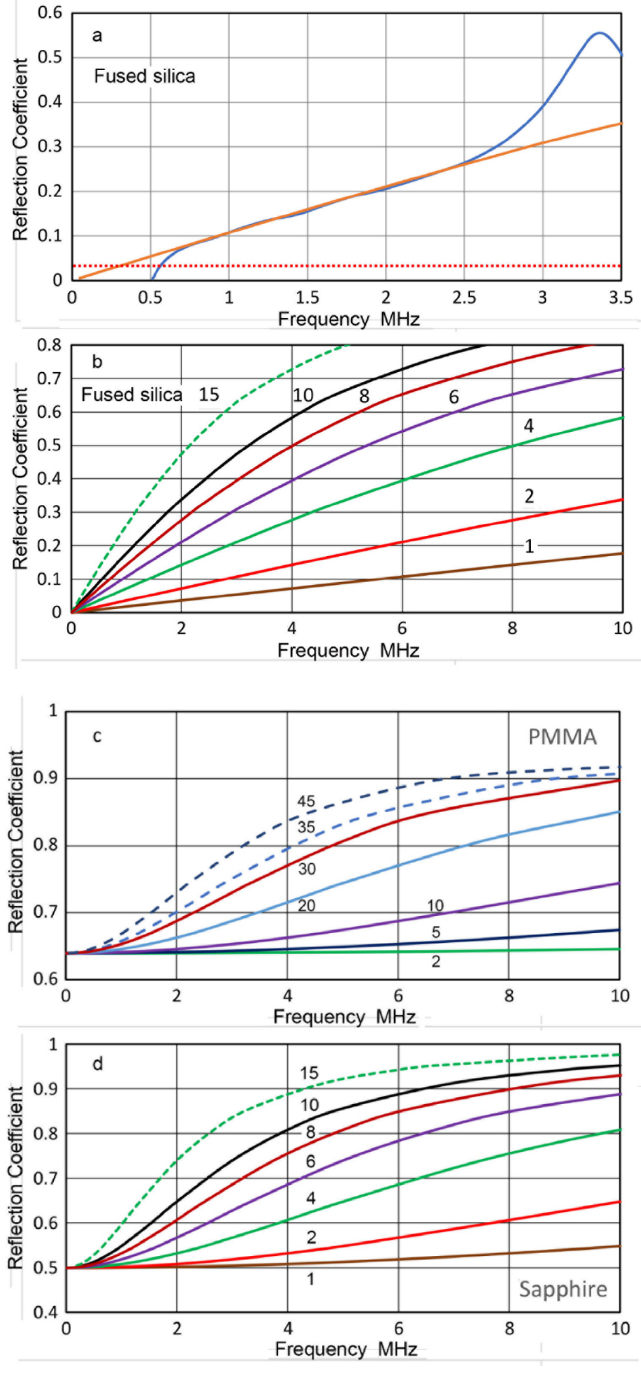
Figure 2. ( a ) Reflection coefficient, R, vs. frequency, f , using BS and IF signals from Figure 1b (blue curve). Calculated R th using Equation (2) (red dotted line) and Equation (3) with 6- µ m couplant thickness (orange curve). ( b ) Reflection coefficient, R th , vs. f for glass-fused silica interface using Equation (3) with couplant thickness of 1 µ m (brown curve), 2 µ m (red), 4 µ m (green), 6 µ m (purple), 8 µ m (dark-red), 10 µ m (black) and 15 µ m (green dashed). ( c ) Reflection coefficient magnitude, |R th |, vs. f for glass-PMMA interface using Equation (4) with couplant thickness of 2 µ m (green curve), 5 µ m (black), 10 µ m (purple), 20 µ m (light-blue), 30 µ m (dark-red), 35 µ m (light-blue dashed) and 45 µ m (blue dashed). ( d ) Reflection coefficient, R th , vs. f for glass–sapphire interface using Equation (4) with couplant thickness of 1 µ m (brown curve), 2 µ m (red), 4 µ m (green), 6 µ m (purple), 8 µ m (dark-red), 10 µ m (black) and 15 µ m (green